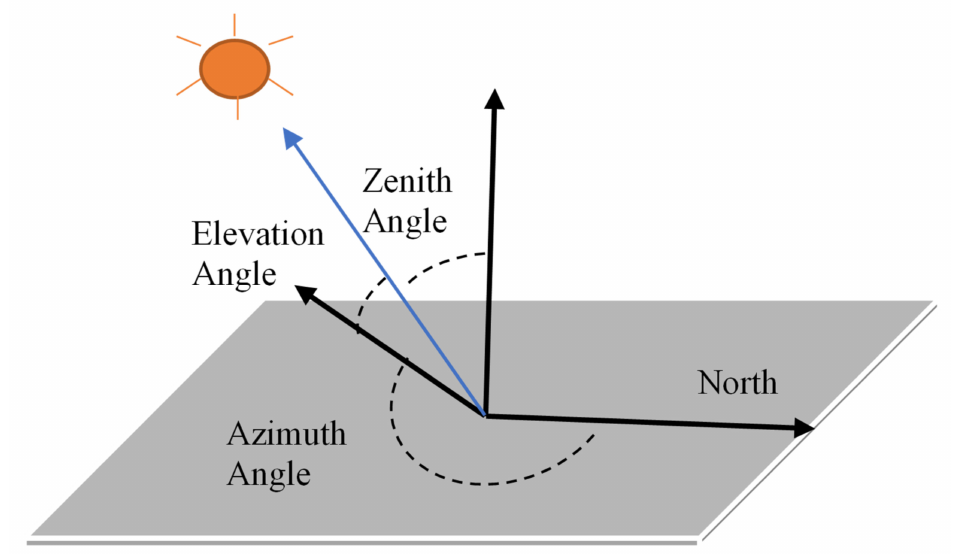
Figure 2. The main angles in PV system